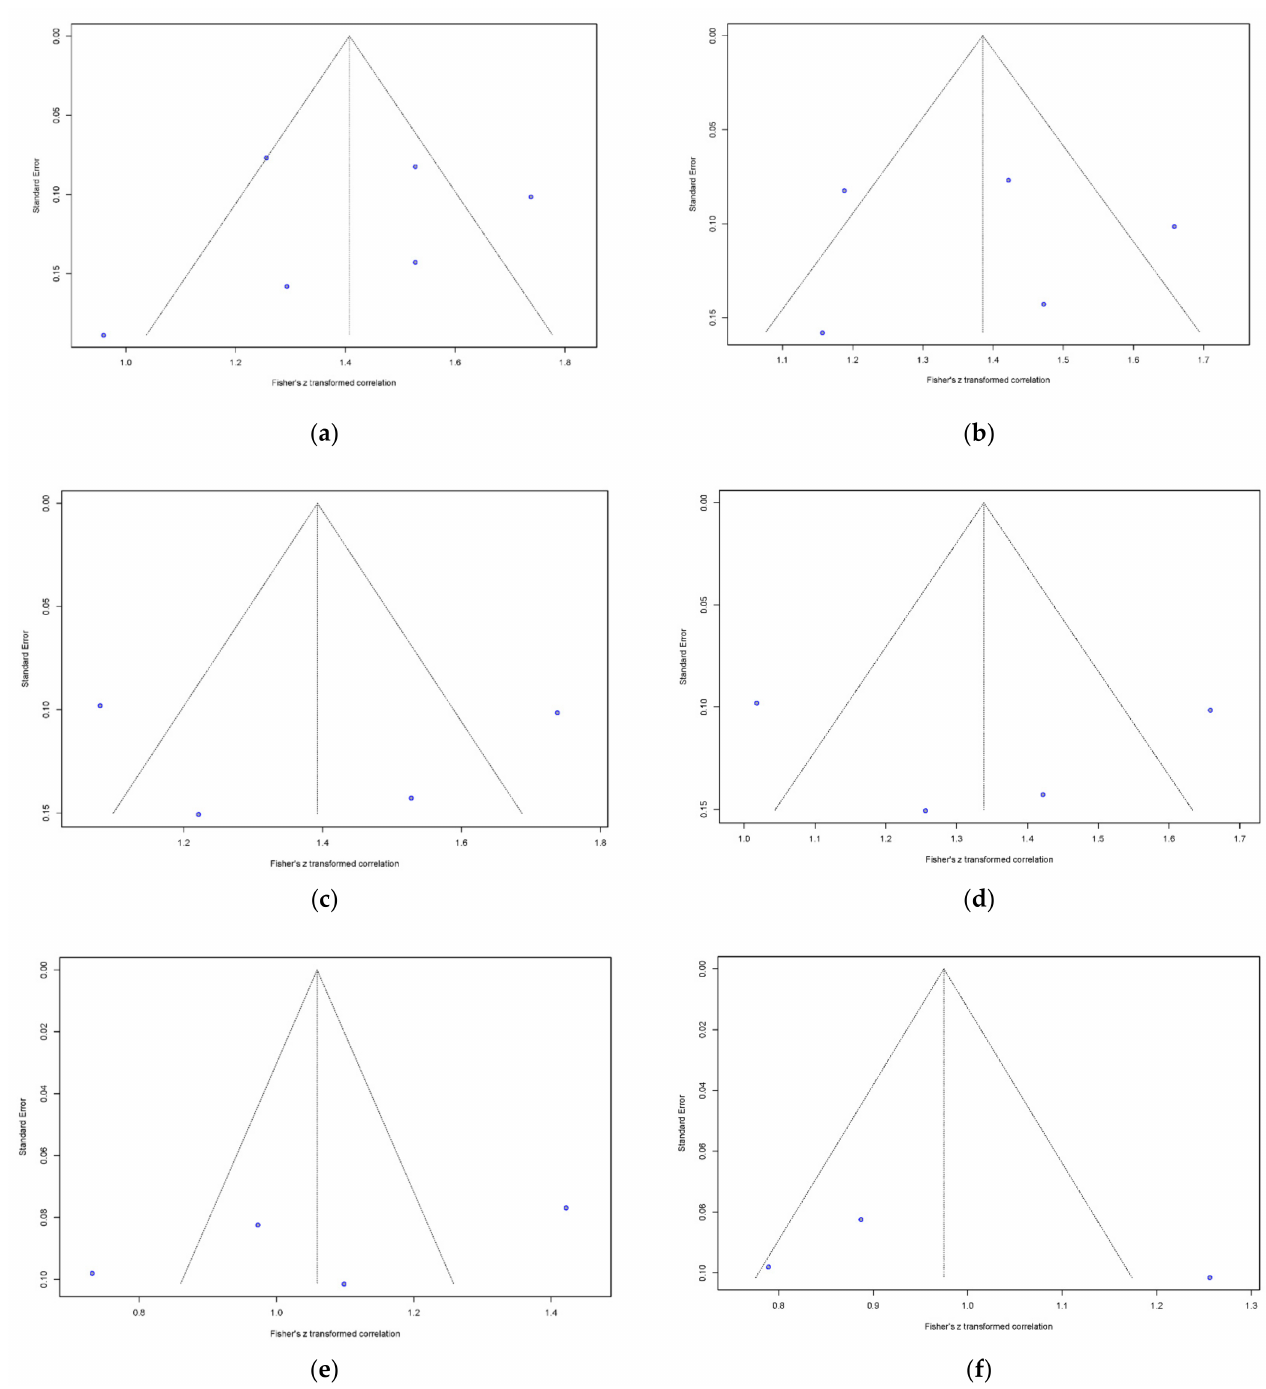
Figure 4. Funnel plots to detect publication bias of correlation between 3D-TEE and MDCT. Bias and p values of asym- metry derived from Egger’s test are shown for annular sizing parameters. ( a ) Aortic annular area (bias = − 1.40, p = 0.67); ( b ) Aortic annular perimeter (bias = 0.15, p = 0.97); ( c ) Annular area-derived diameter (bias = 0.11, p = 0.99); ( d ) An- nular perimeter-derived diameter (bias = 0.92, p = 0.92); ( e ) Annular maximum diameter (bias = − 16.67, p = 0.34); ( f ) Annular minimum diameter (bias = 10.36, p = 0.69). 3D-TEE = Three-dimensional transesophageal echocardiography, MDCT = Multidetector computed